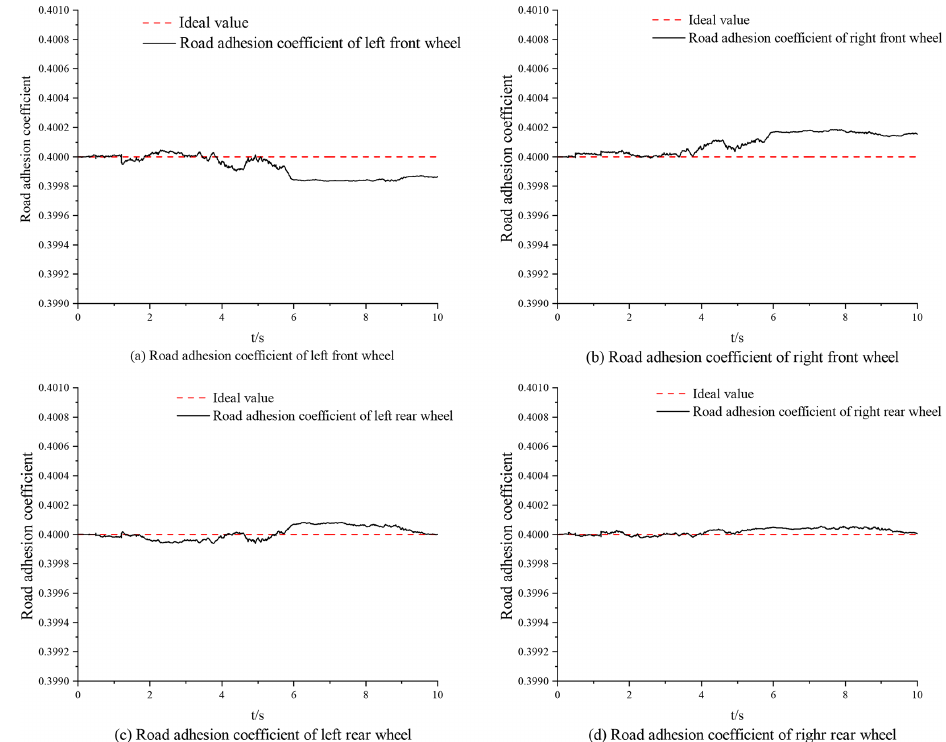
Figure 8. The low-adhesion road surface identification effect based on the PF algorithm.